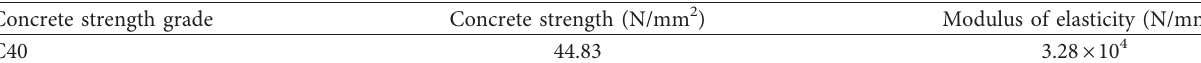
Table 3: Mechanical properties of the concrete.